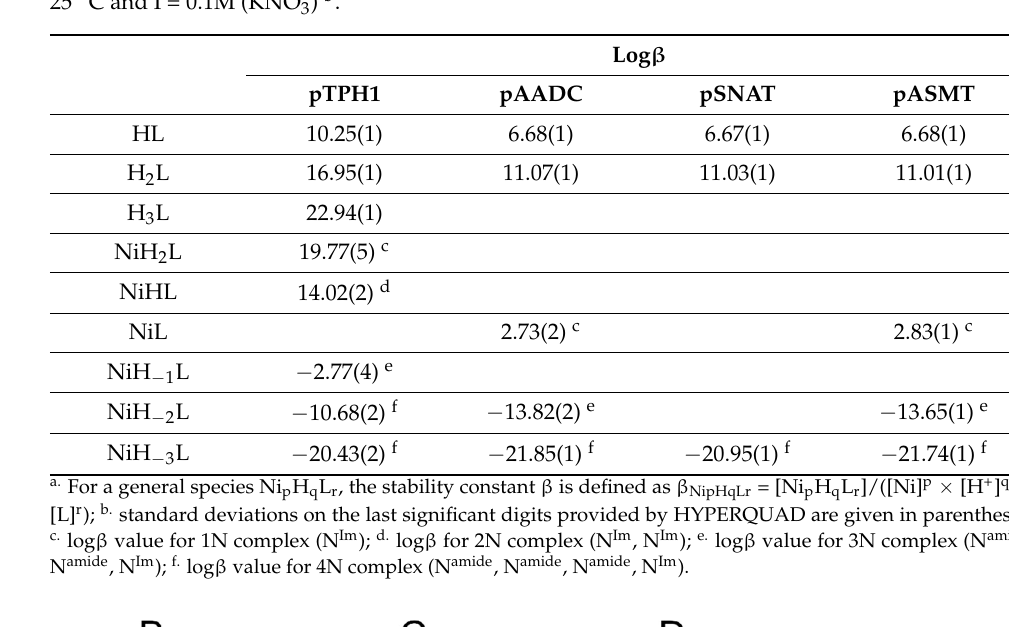
Figure 4. CD spectra of 0.95:1.00 mixtures of Ni(II) ions with the respective peptides, pTPH1 ( A ), pAADC ( B ), pSNAT ( C ), and pASMT ( D ), obtained for different pH values, starting from 3.5 (red) to 10.5 (blue). The spectra for apopeptides are represented by black dotted lines (near zero circular dichroism). The arrows mark the pH-dependent appearance of the d-d band characteristic for hy- drolytic square planar 4N Ni(II) complexes.